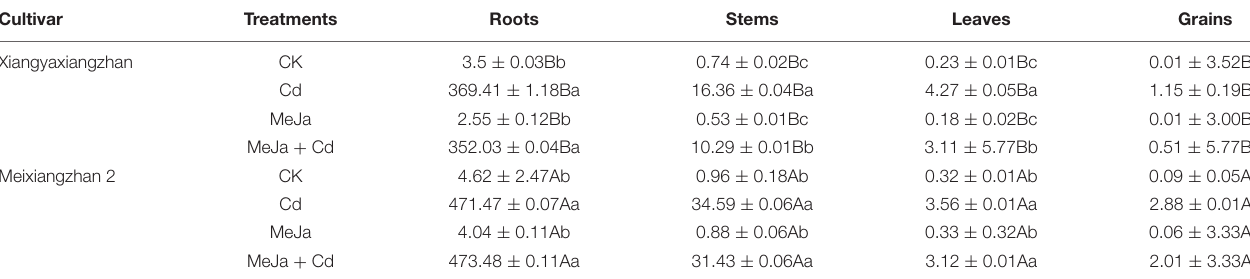
The values are representative of three replicated means per treatment ± SE. Different letters indicate significant differences between cultivars and treatments at p < 0.05, LSD.